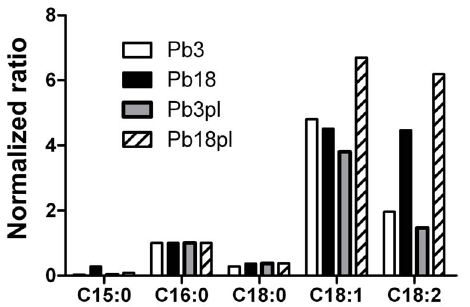
Figure 2. Number of phospholipid species from each class identified in Pb3 and Pb18 cell wall cultivated in the absence of plasma. ESI-MS/MS analysis in both negative- and positive-ion modes. Detailed description of individual phospholipid species is found in Table 1.